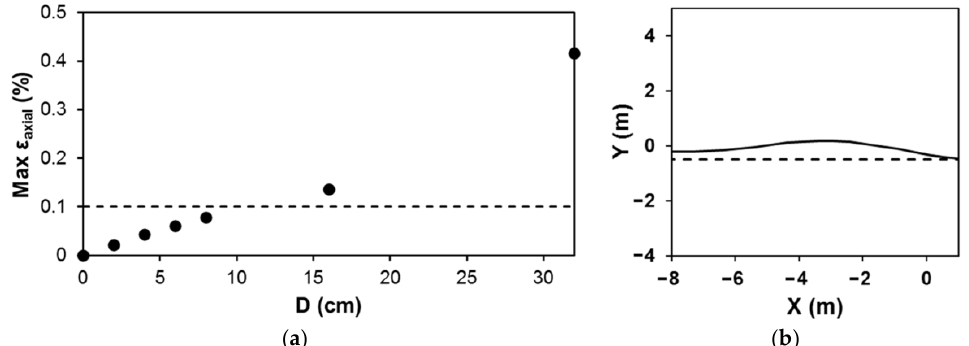
Figure 14. ( a ) Maximum axial strains of the submarine power cable for different net bedrock displacements, and ( b ) the actual displacement of the cable at the fault rupture zone.